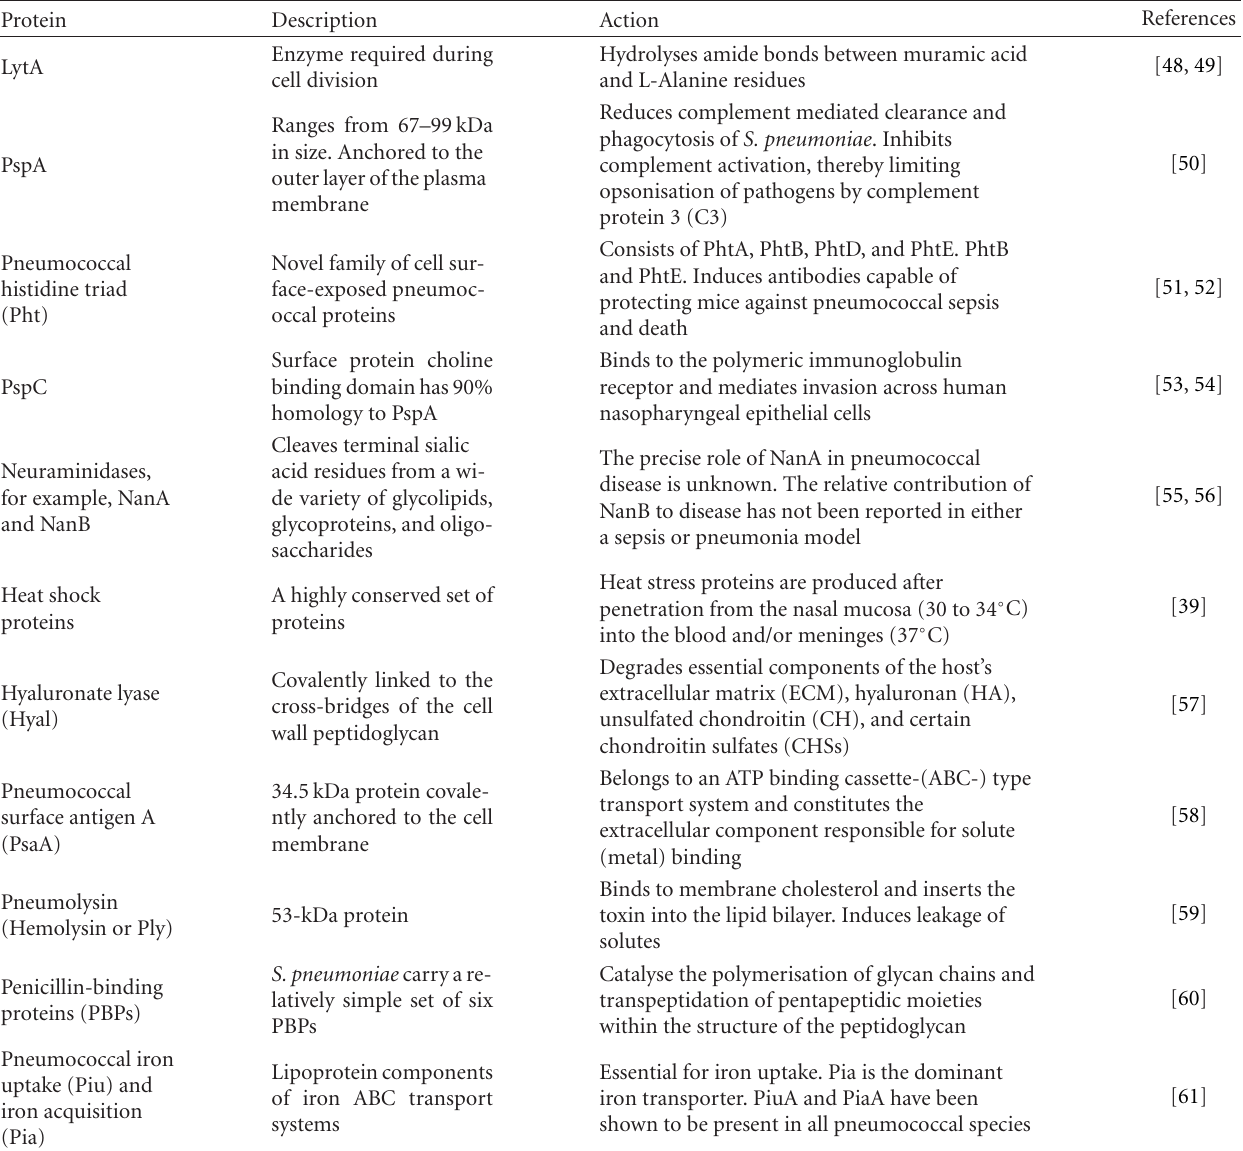
Table 1: The cell wall of S. pneumoniae has a diverse protein population, and pathogenic expression of pneumoccal proteins are associated with adherence to and colonisation of mucosal surfaces, resistance to specific and nonspecific host defences, penetration and invasion of host tissues, and generation of tissue damage mediated either directly by toxins or indirectly via inflammatory